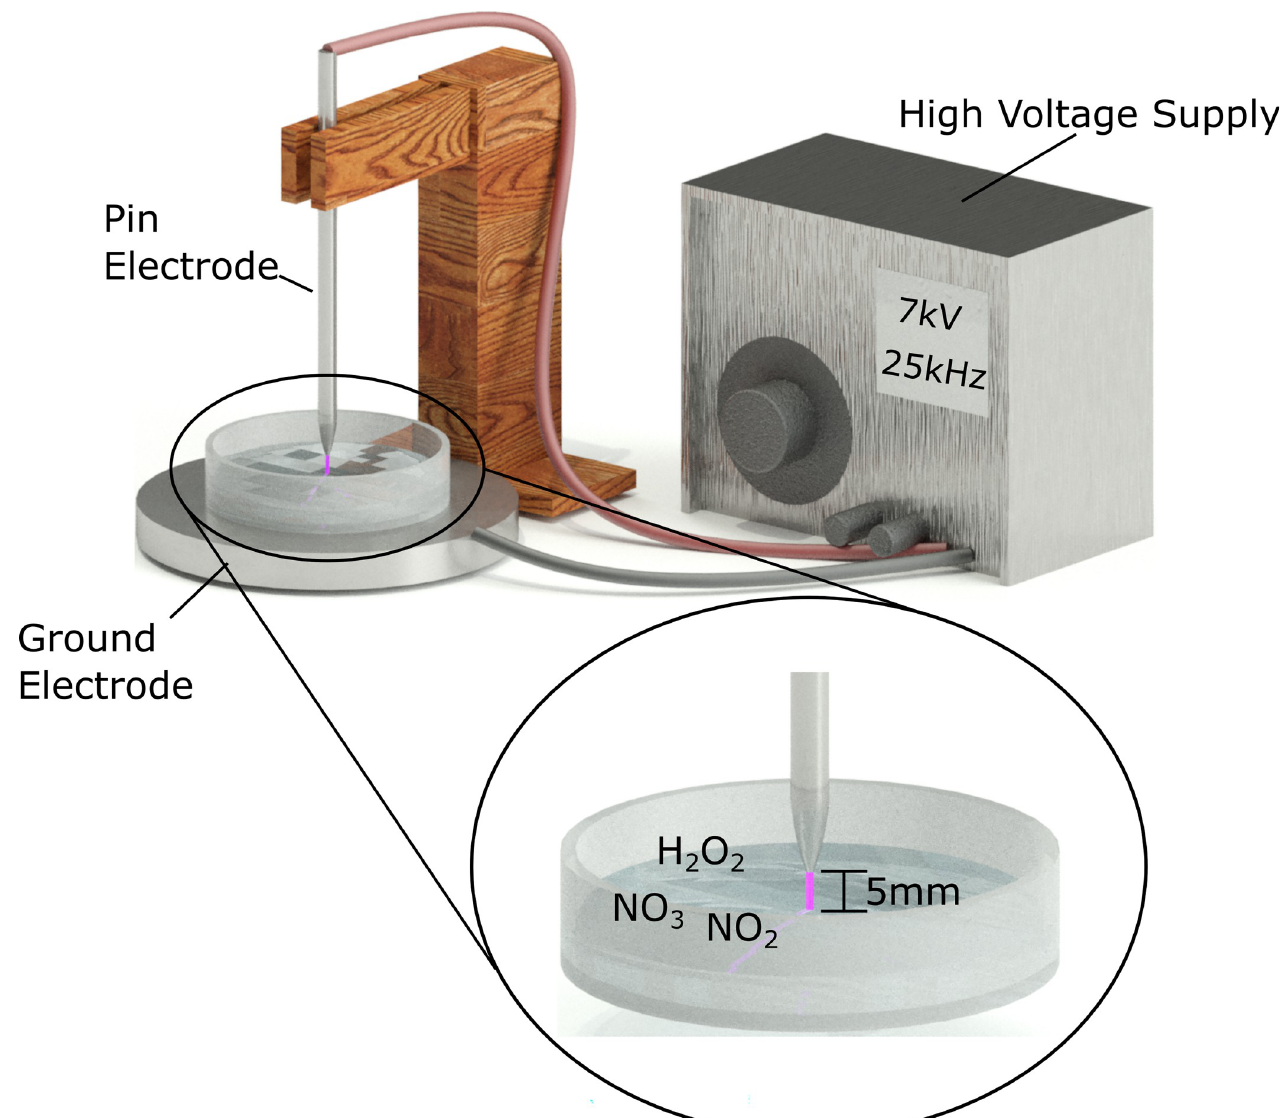
Fig 1. A schematic illustration of the PAL generation device prototype used in this